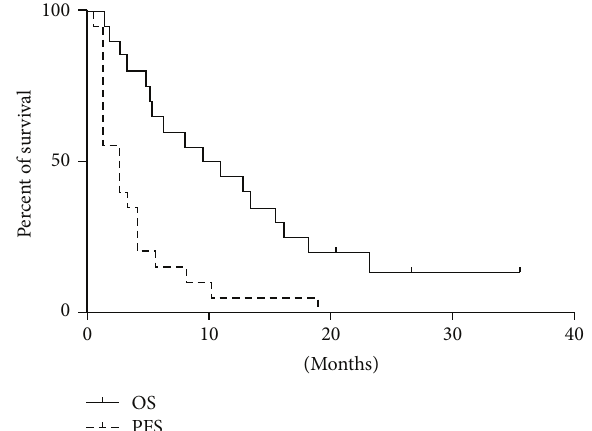
Figure 1: Kaplan-Meier graph is shown with progression-free survival (PFS) and overall survival (OS) for all patients enrolled in the study.